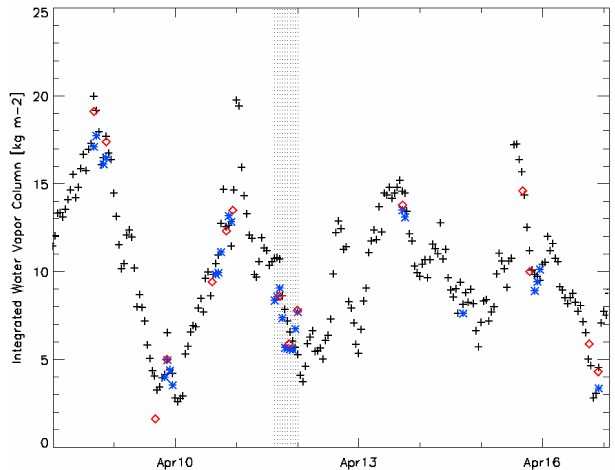
Figure 8. Time series of the lidar calibration factors for the RMR- H2O lidar determined by IWV GPS, IWV RS92 and PROF RS92 approaches (black crosses, red diamonds and green squares, respec- tively) for the period 8–16 April. Dashed horizontal lines indicate the median values for each method. Dotted vertical lines highlight the lidar measurement session acquired between 15:00 UTC of the 11 April and the 00:00UTC of 12 April 2013.